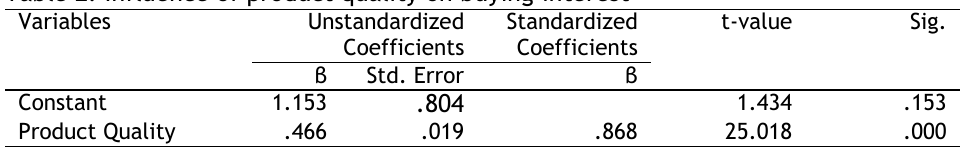
Table 2. Influence of product quality on buying